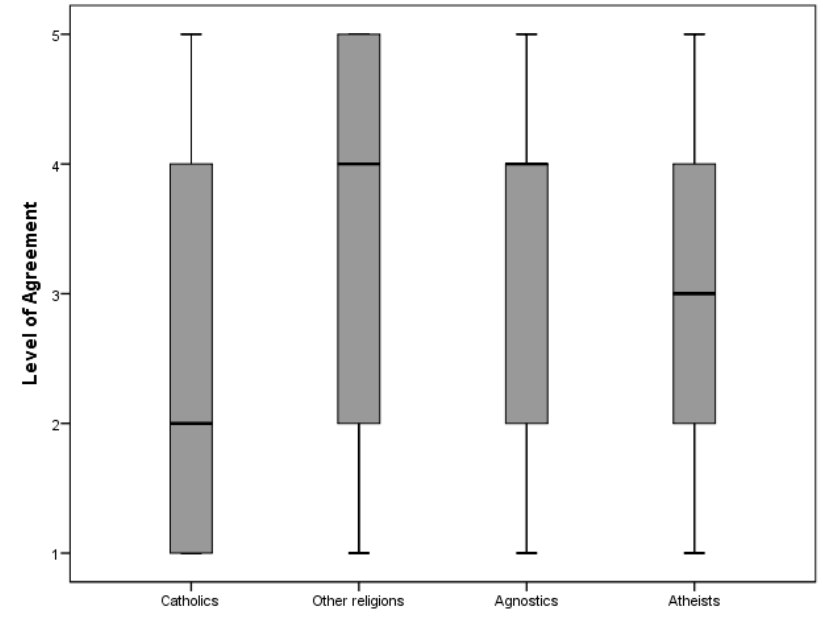
Figure 1. Box-plots showing degree of agreement on limiting population growth for environmental reasons by different religious groups.